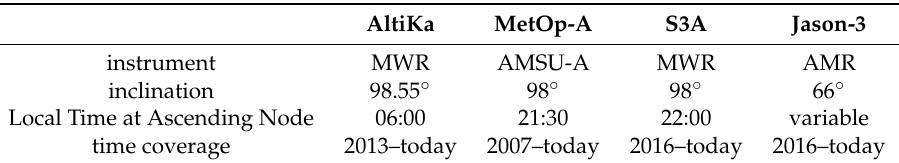
Table 2. Mission